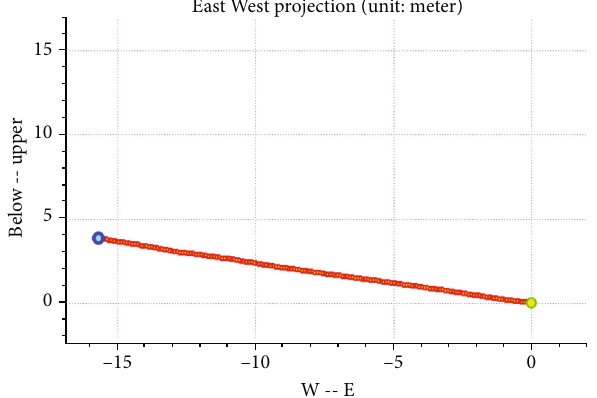
Figure 13: East-West projection of gas drainage